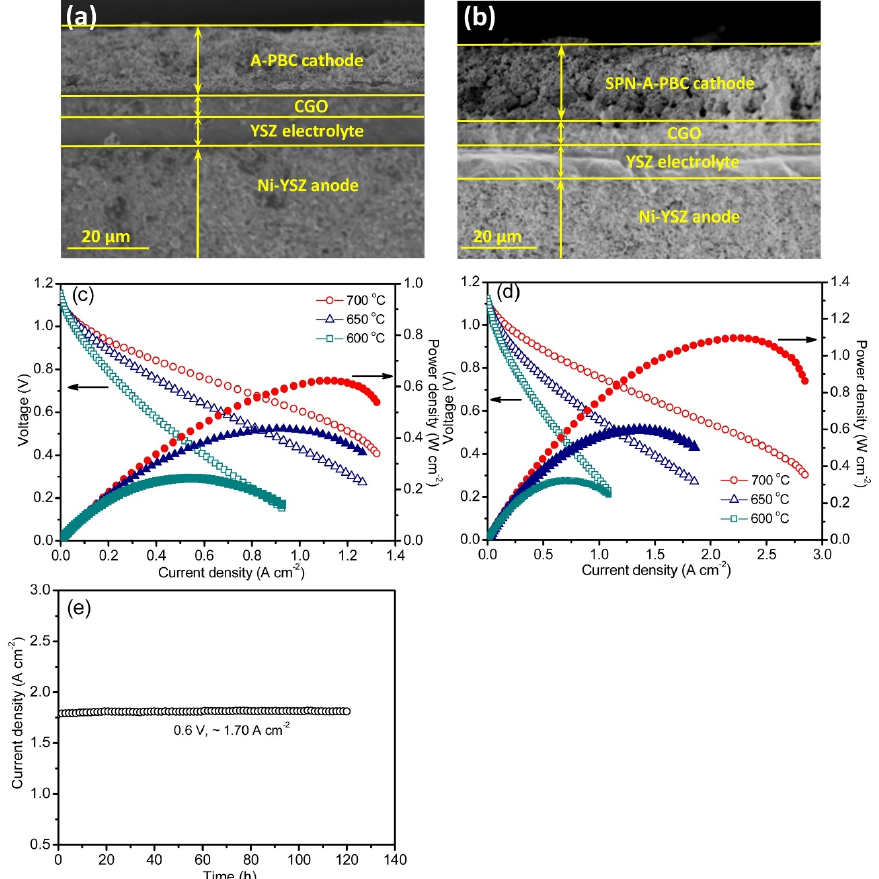
Figure 6. Cross-section view of SEM images of the anode-supported single cell with a Ni–YSZ anode, an YSZ electrolyte, a CGO buffer layer and the ( a ) A–PBC and ( b ) SPN–A–PBC cathodes. V – I and P –